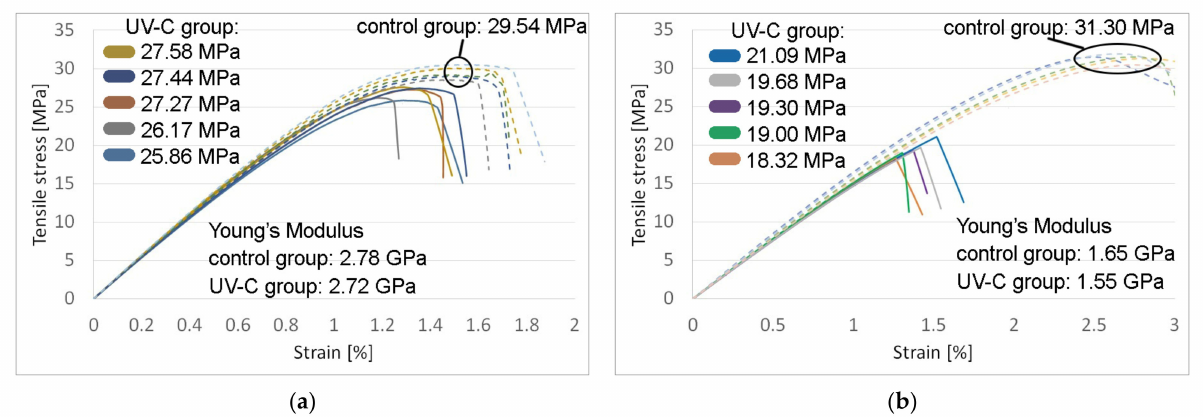
Figure 5. Tensile strength testing results, with Young’s Modulus and tensile stress at tensile strength: ( a ) PLA UV-C exposed group (solid) and control group (dashed); ( b ) PETG UV-C exposed group (solid) and control group